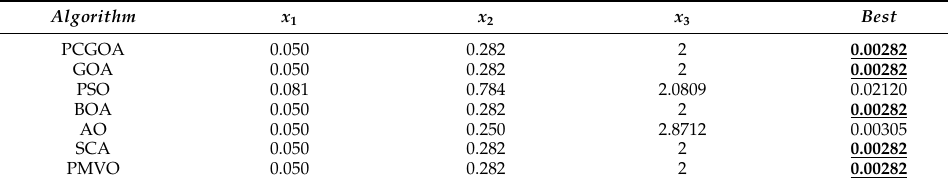
Table 4. Comparison results of each algorithm for the tension spring design problem.